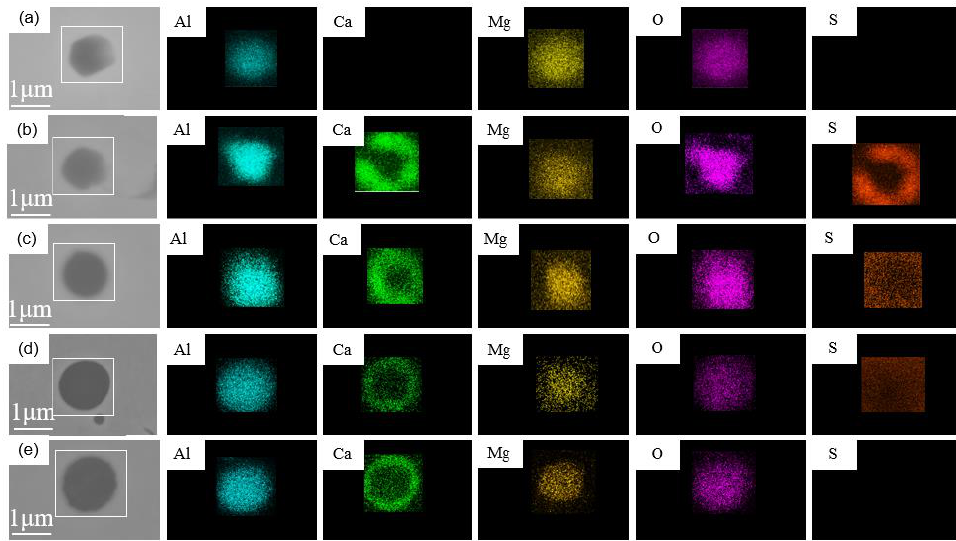
Figure 6. Typical inclusions when adding Ca after Mg ( a ) 30 s after Mg addition, ( b ) 30 s after Ca addition, ( c ) 5 min after Ca addition, ( d ) 15 min after Ca addition, ( e ) 30 min after Ca addition.